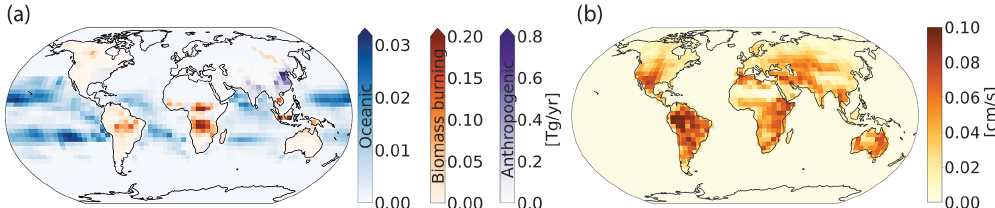
Figure 2. (a) Average annual global emissions of H 2 in Tgyr − 1 from 2015 and 2016 from biomass burning (red), oceanic (blue) and anthropogenic (purple) sources. Anthropogenic emissions include fossil fuel and biofuel combustion. Note the difference in scales for the different source types. (b) Average annual dry deposition velocity of H 2 in centimeters per second (cms − 1 ) supplied into GEOS-Chem and determined from the original calculations from Yashiro et al.